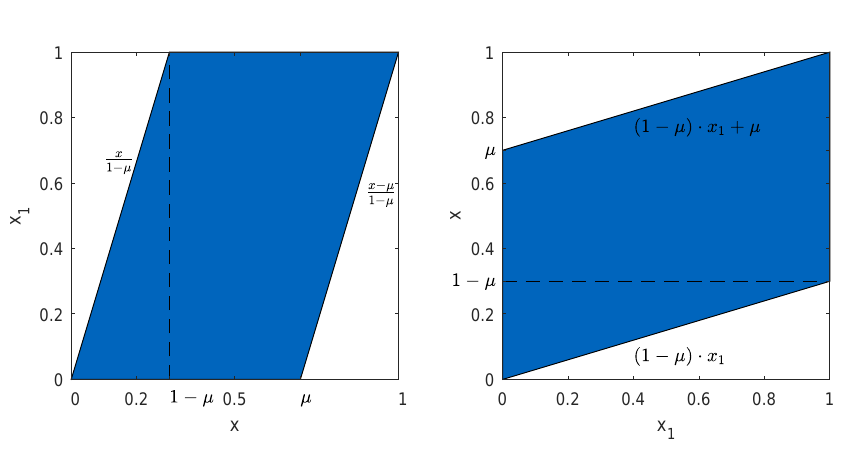
Figure A1. Region of x and x 1 that results in a valid complement x 2, c 1 ; for illustration purposes, µ was set to